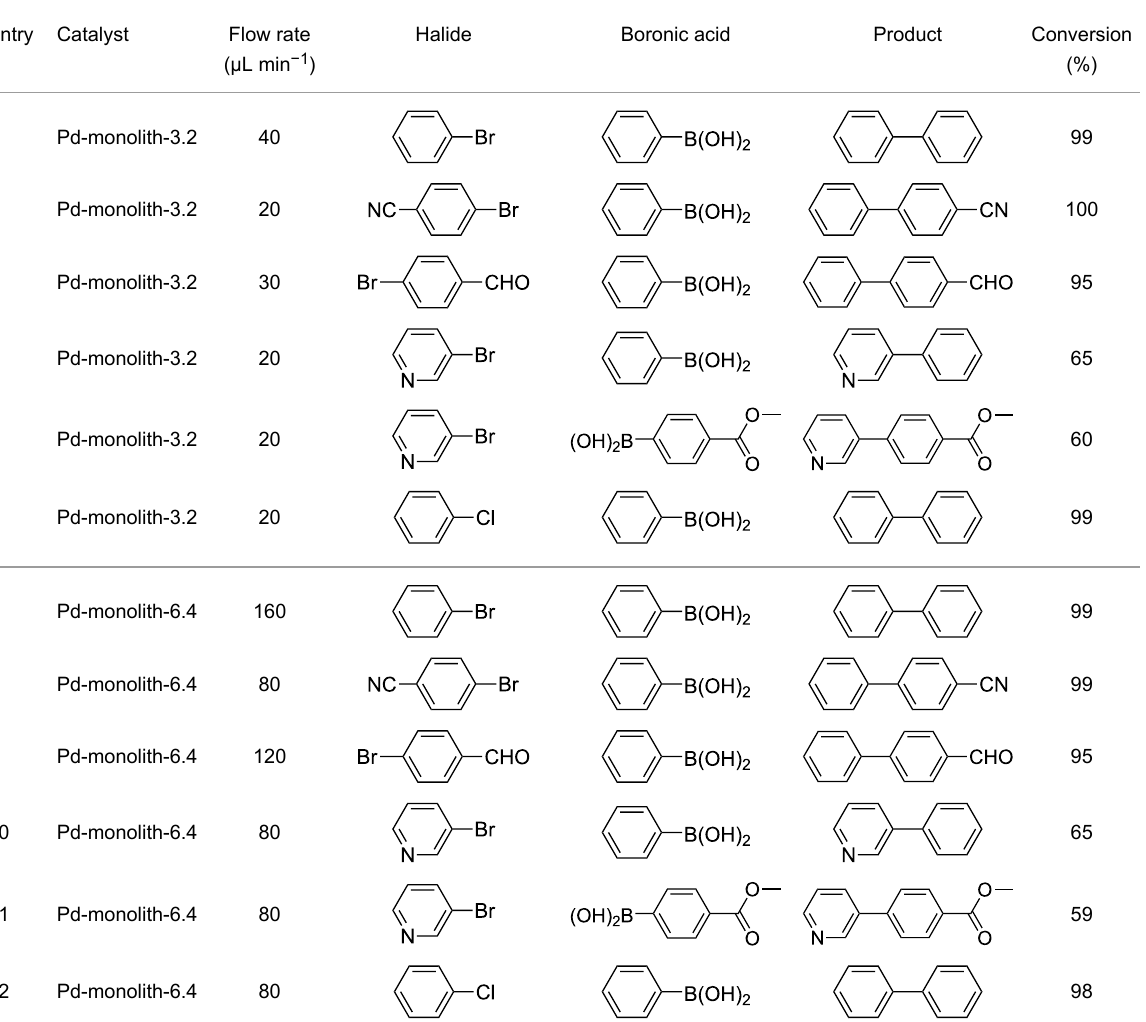
Table 3: Reactivity of Pd-monoliths with different diameters, in the Suzuki–Miyaura reaction between various reactants under continuous-flow condi- tions. a